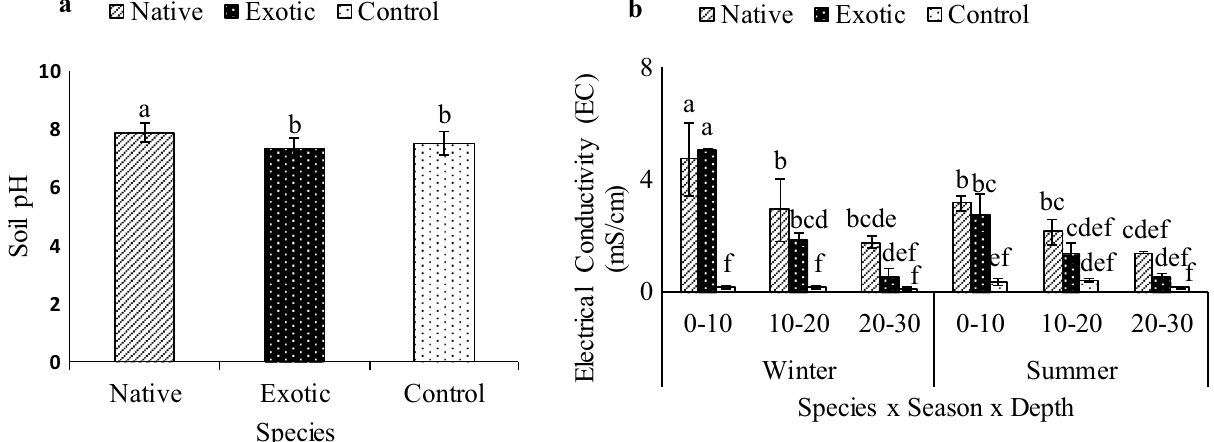
Figure 2. Effects of Tamarix species (native and exotic) on ( a ) soil pH and ( b ) electrical conductivity in Leeu River at three soil depths (0–10, 10–20 and 20–30 cm), in two seasons (winter and summer). Means followed by different letters are significantly different from each other (Turkey’s test HSD). Bars indicate standard deviation from the means.